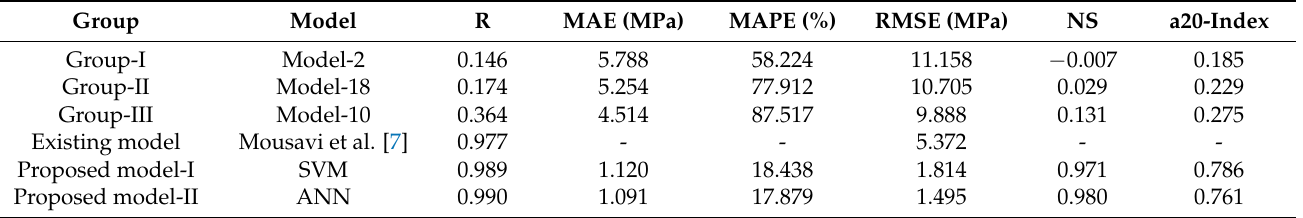
Table 7. Performance indices of the best model from each group I, II, III, and proposed SVM and ANN